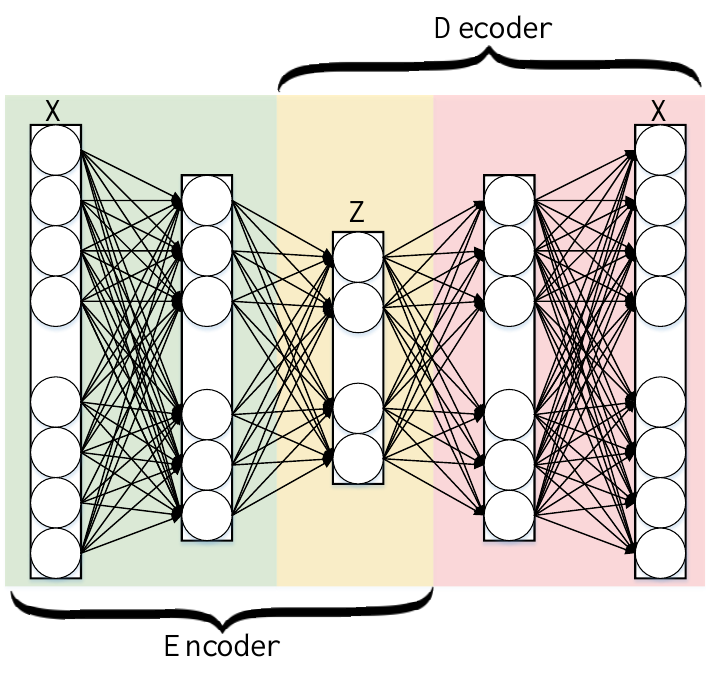
Figure 6. This figure shows how a simple autoencoder works. The model depicted contains the following layers: Z is code and two hidden layers are used for encoding and two are used for